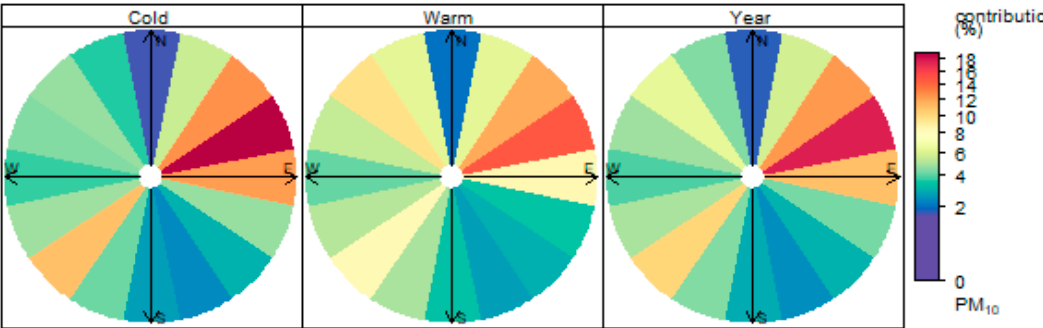
Figure 7. PM 10 weighted concentration rose (except for the wind speed parameter), the V ěřň ovice site, 2011–2020.